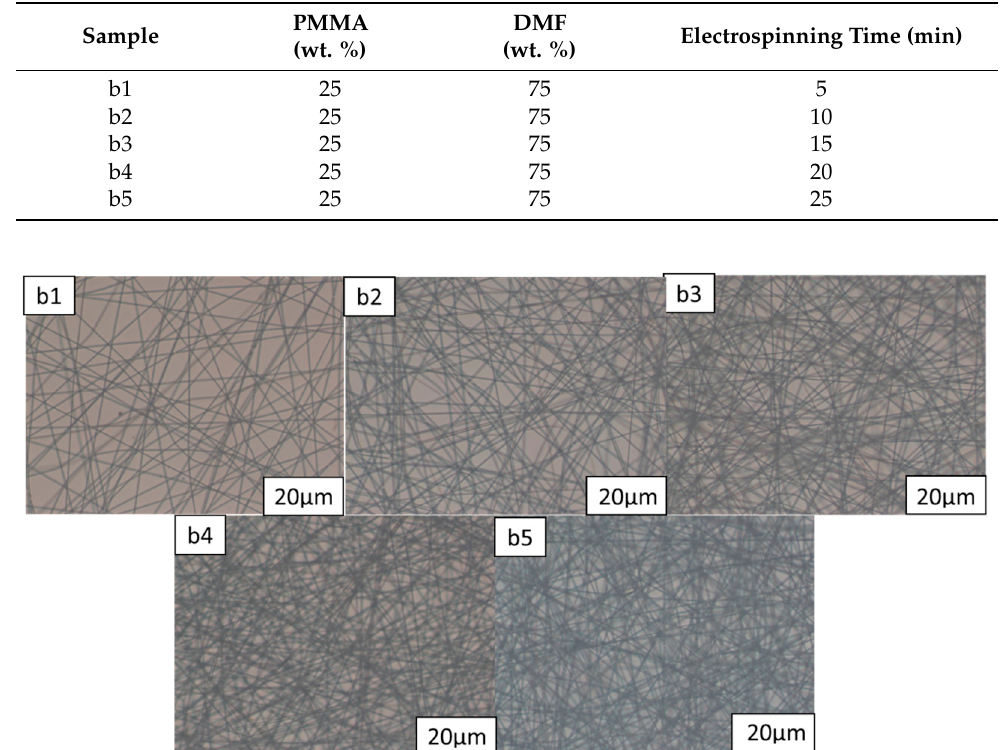
Figure 3. Polarized optical microscopy (POM) of nanofibers of ( b1 – b5 ).